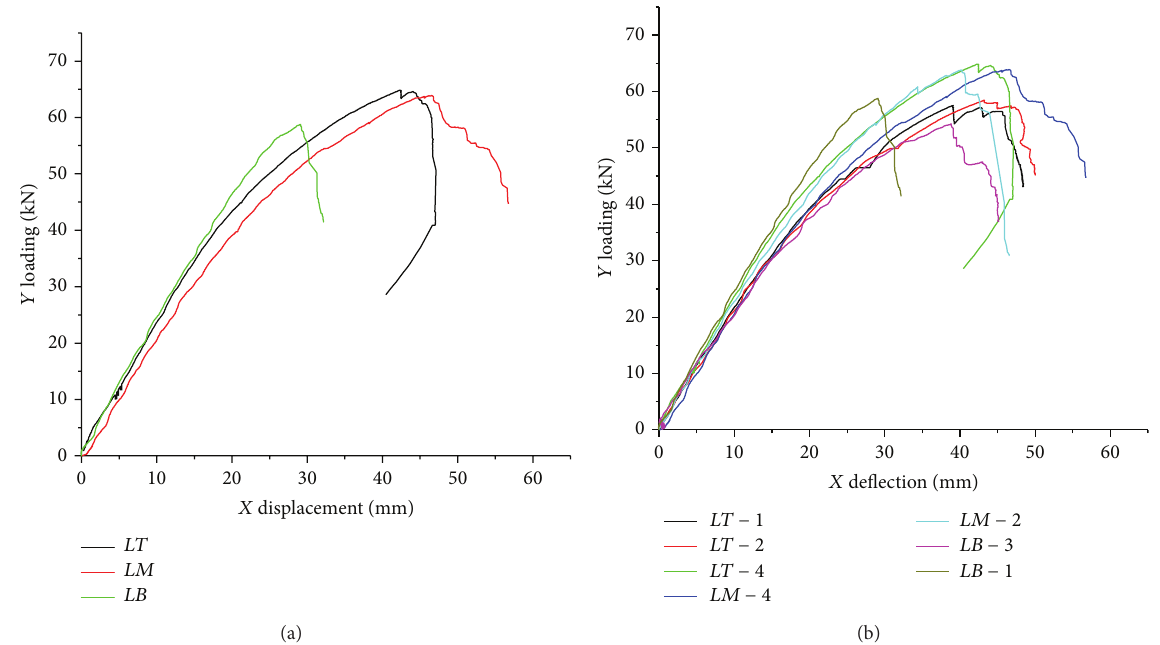
Figure5:(a)LoadversusmidspandeflectiontypicalcurvesofPSBbeamsthetip.mid.bottom,respectively.(b)Loadversusmidspandeflection curves of most